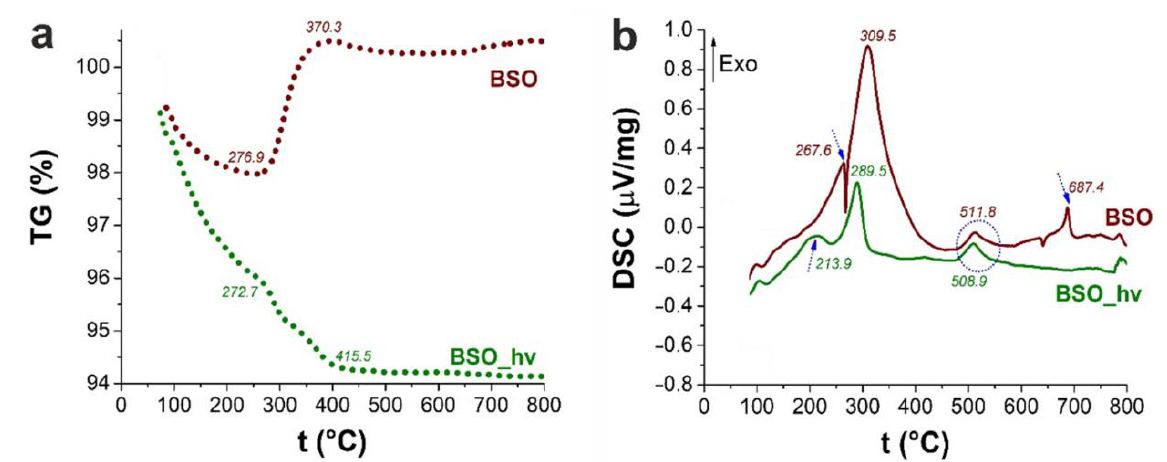
Figure 5. TG ( a ) and DSC ( b ) data for the BSO (brown color) and BSO_hν (green color) groups of materials.